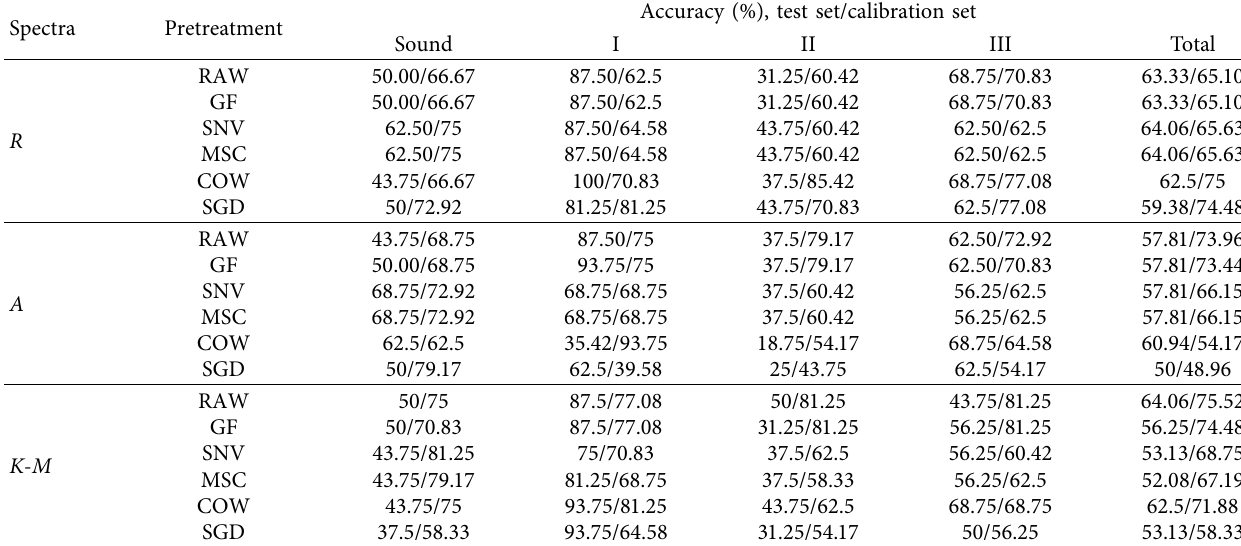
Table 1: Discriminant accuracy of the PLS-DA model based on R , A, and K - M spectra.